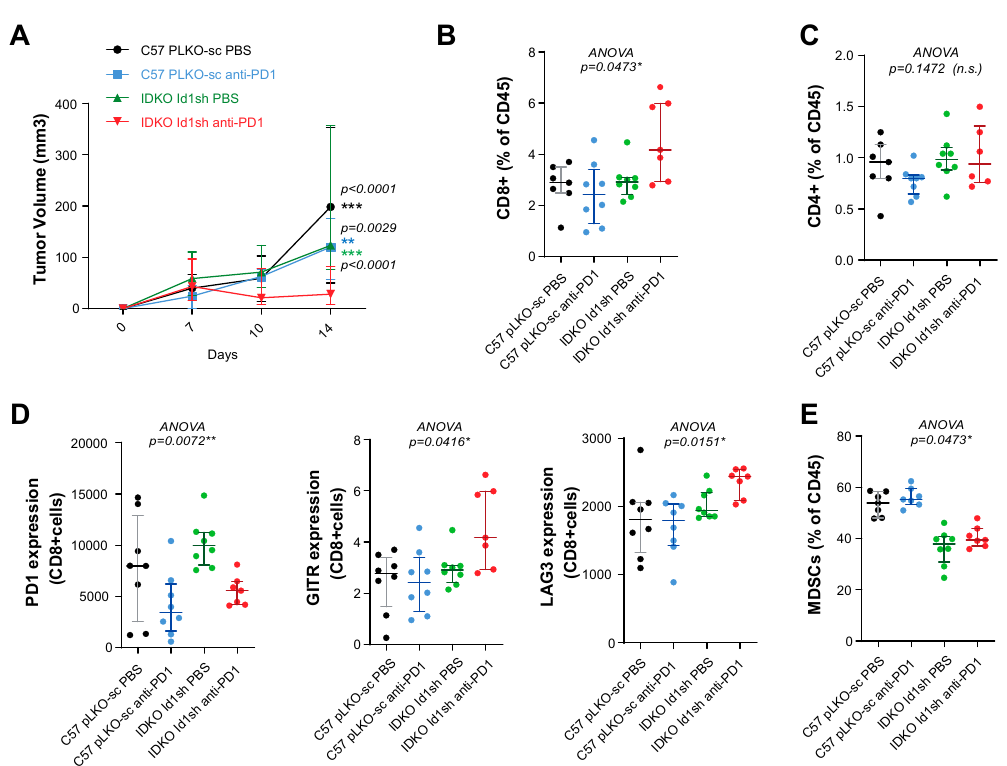
Figure 6. The antitumor activity observed after the Id1 and PD-1 blockade is mediated by CD8 + T cells. ( A ) Tumor growth of LLC (pLKO-sc or Id1sh) cells in mice (C57BL / 6J or IDKO) treated with DPBS or anti-PD-1 for endpoint flow cytometry analysis (final tumor volume per group: Id1 - / - / anti-PD-1: 28.04 [21.42–65.61]mm 3 ; Id1 - / - / DPBS:123.3[82.24–227.2]mm 3 , p < 0.0001; Id1 +/+ / anti-PD-1: 120.3[70.97–148.1] mm 3 , p = 0.0029; Id1 +/+ / DPBS: 198.4 [122.6–223.8] mm 3 , p < 0.0001). ( B ) Flow-cytometric analysis of CD8 + T cells in tumors harvested at day 14. ( C ) Flow-cytometric analysis of CD4 + T cells in tumors harvested at day 14. ( D ) Flow-cytometric analysis of PD-1, GITR and LAG3 markers (expressed as mean fluorescence intensity on CD8 + T cells) in LLC tumor grown the same mice as in A. ( E ) Flow-cytometric analysis of MDSCs cells in tumors harvested at day 14. The data are reported as the median with the interquartile range. * p < 0.05, ** p < 0.01, *** p < 0.001, n.s. (not significant).